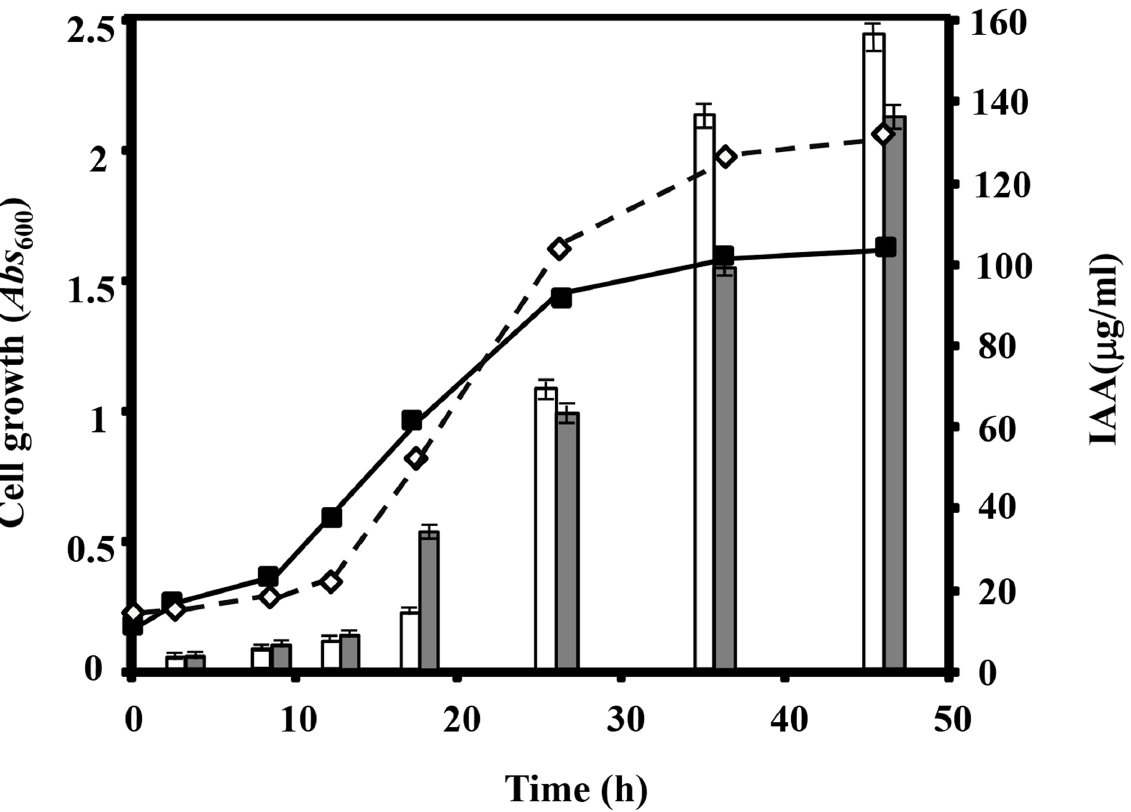
Figure 1. Azoarcus sp. CIB produces IAA. Production of IAA by Azoarcus sp. CIB (white bars) and R. leguminosarum bv. trifolii TT-7C (grey bars) along the growth curve. Growth of Azoarcus sp. CIB (black squares) and R. leguminosarum bv. trifolii TT-7C (grey rhombus) is also represented. IAA was quantified as detailed in Materials and Methods. Graphed values of are the average from three independent experiments + / 2 S. D.